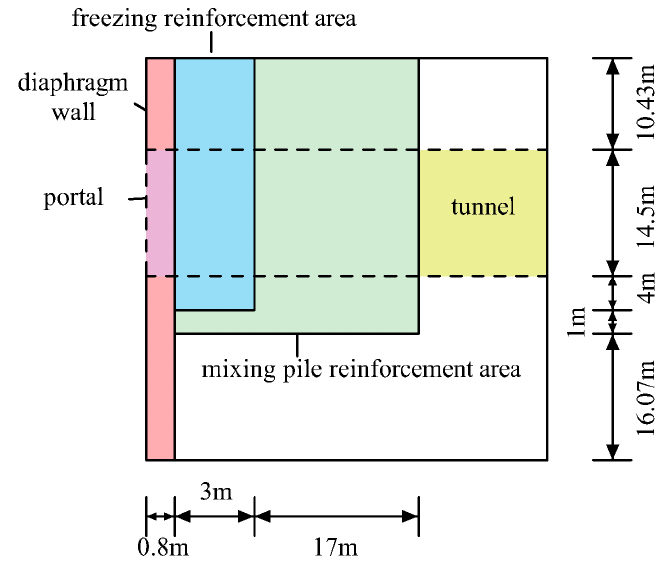
Figure 3. The schematic diagram of the Wuhu River-Crossing Tunnel end reinforcement.